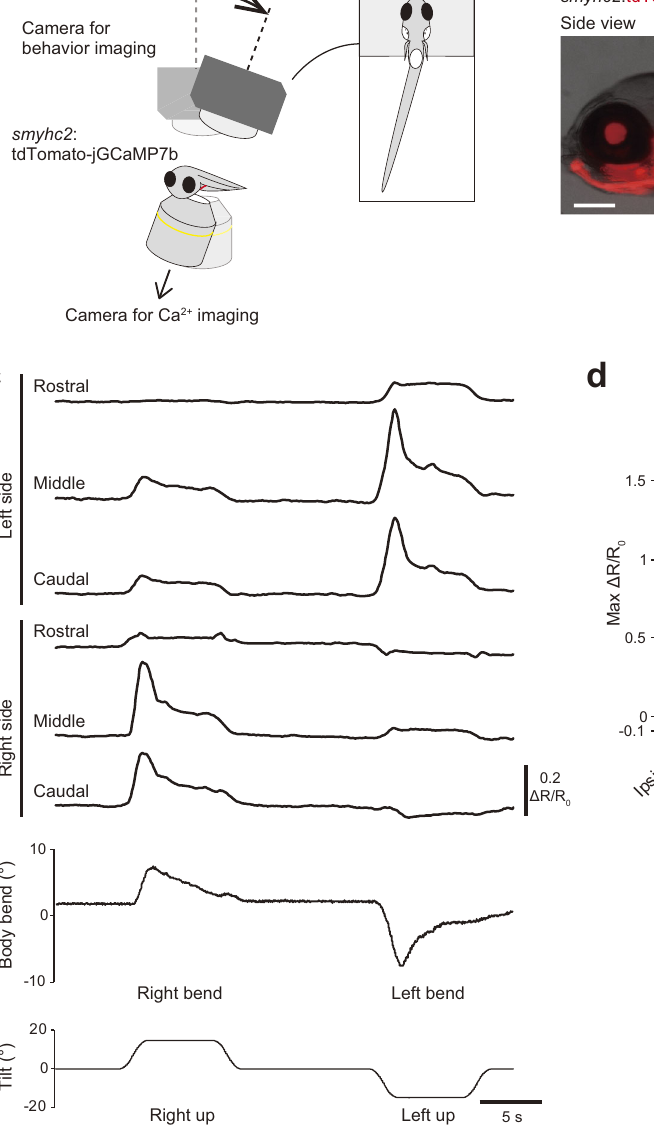
(greenish signal) derived from intestine and yolk is present in the middle. Scale bars,200 μ m. c Timecourseof Δ R/R 0 ineachsegmentofslow-typePHMsandbody bend angles in response to a roll tilt. d Pairwise comparison of maximum Δ R/R 0 in each segment of slow-type PHMs between ipsi-down and ipsi-up tilts (six fi sh). A single trialoraverage values oftwo trials areshownfor each fi sh. p =0.01 forthe rostral, p =0.02forthemiddle,and p =0.0006forthecaudalsegments(two-sided paired samples t test). Source data are provided as a Source Data fi